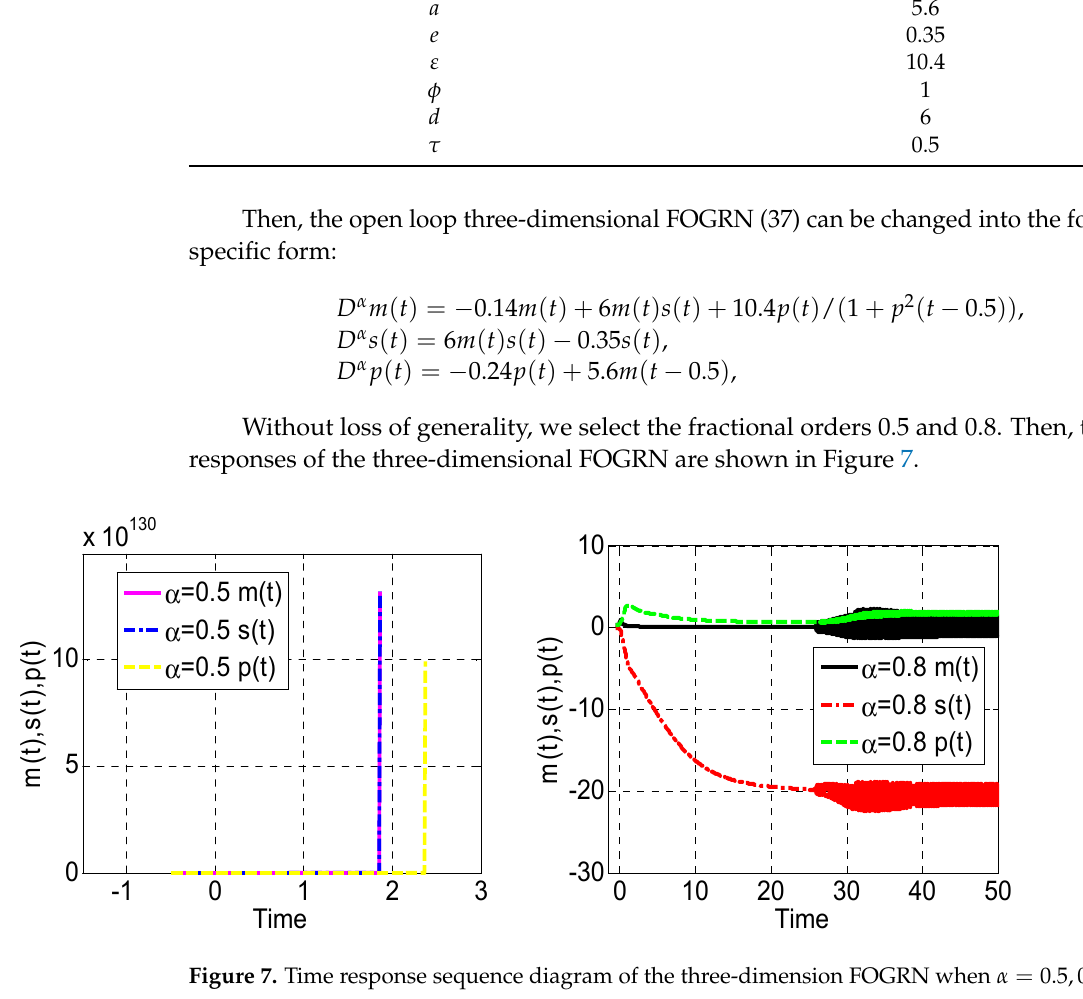
Table 2. The structural parameters of the three-dimensional FOGRN.